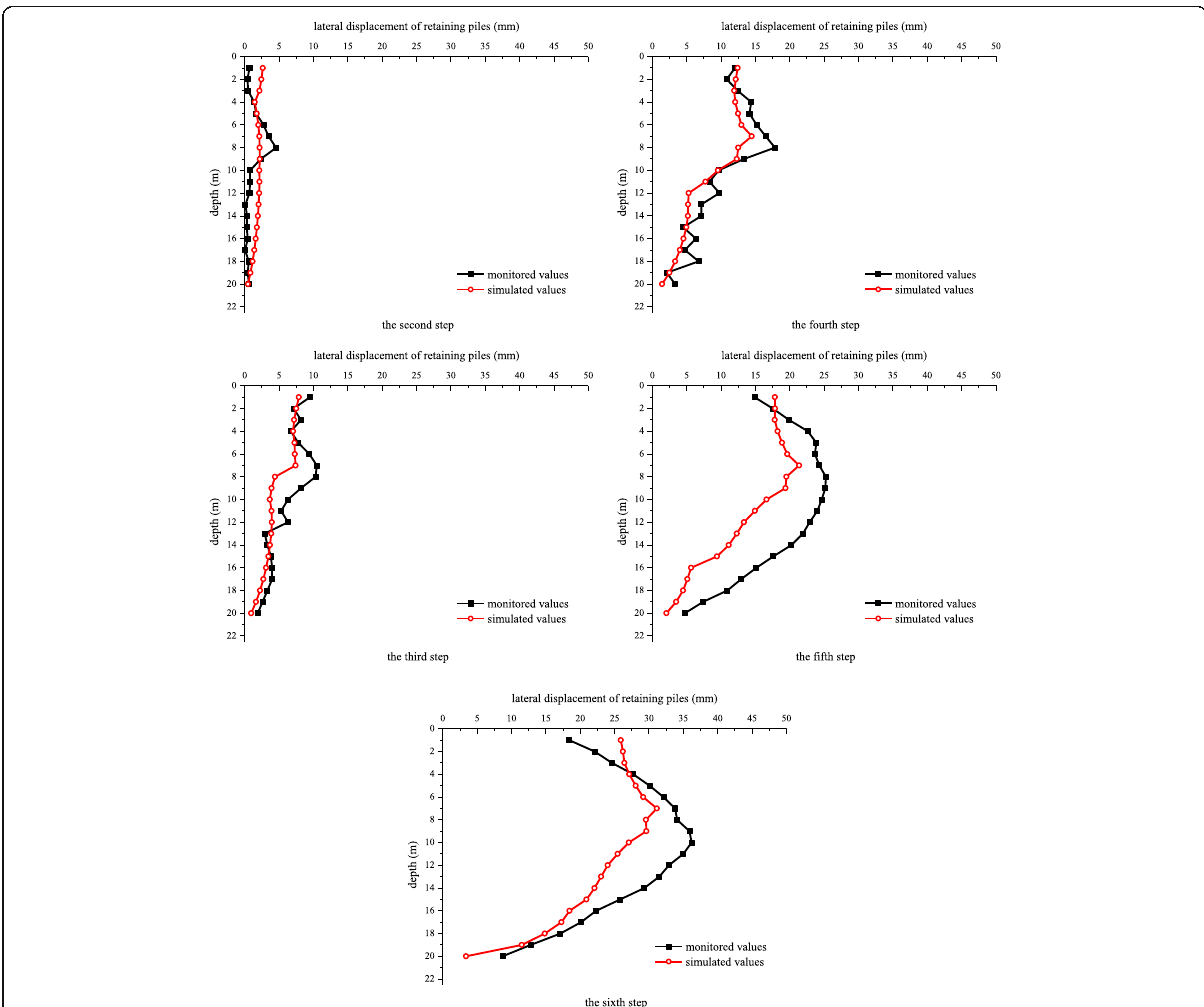
Fig. 10 Monitored and simulated lateral displacements of point